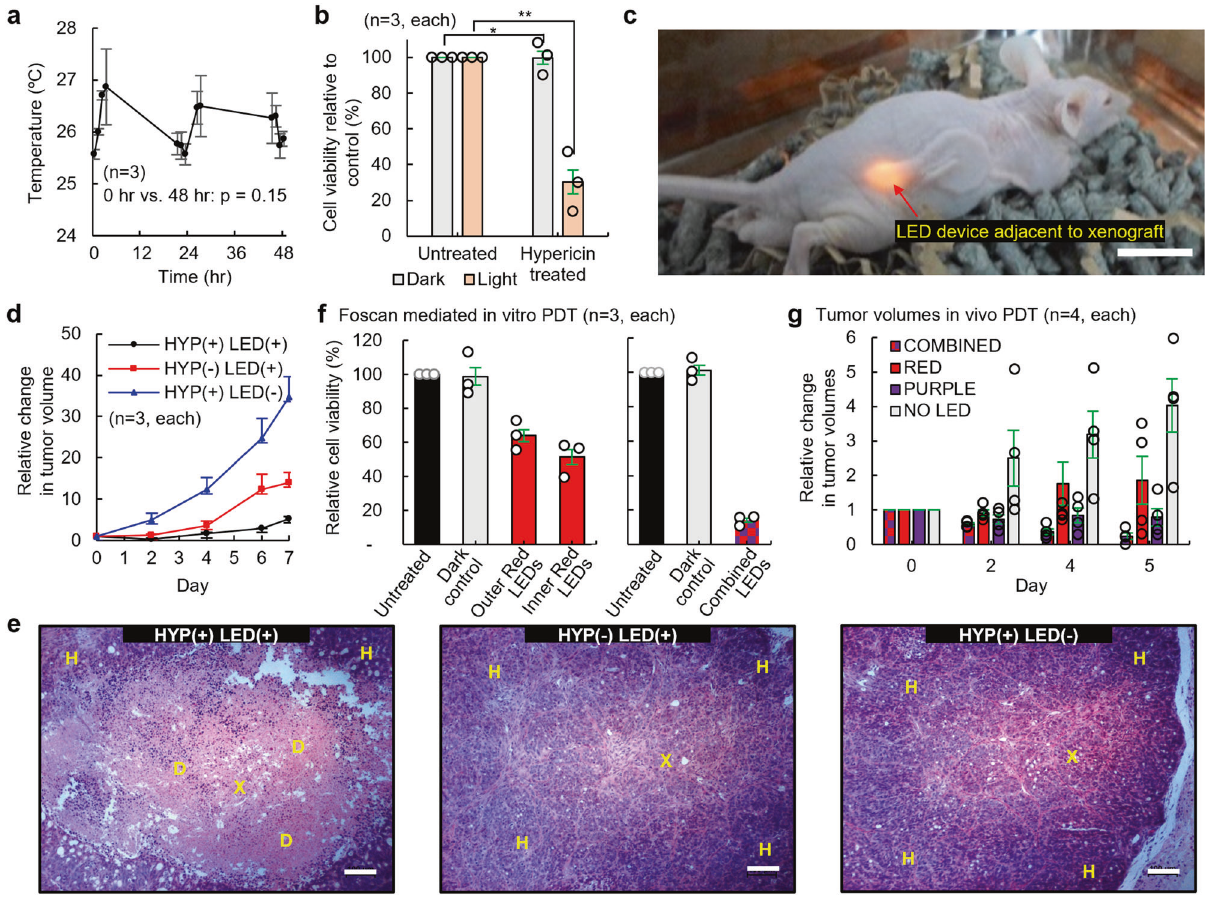
Fig. 5 Hypericin and Foscan mediated in vitro and in vivo PDT. a LED devices were continuously switched on and the operating temperatures of devices were measured over 48 h. b HT29 cells were seeded into 24-well plates and incubated with 200 nM Hypericin in the dark. LEDs were positioned under the wells and cells were treated with 36 mJ cm − 2 of light for an hour. After 24 h, cell viability was assessed. Subcutaneous HT29 tumor xenografts were generated in BALB/c nude mice and the LED devices implanted adjacent to tumor xenografts. LEDs were switched on and Hypericin was administered every 24 hours to a total of 3.5 mg kg − 1 of Hypericin and 12.1 J cm − 2 of light. c Photograph of a mouse with a device implanted; scale bar 1 cm. d Tumor volumes were recorded for a week. The HYP( − )LED( + ) group received LED light treatment only. The HYP( + )LED( − ) group received Hypericin